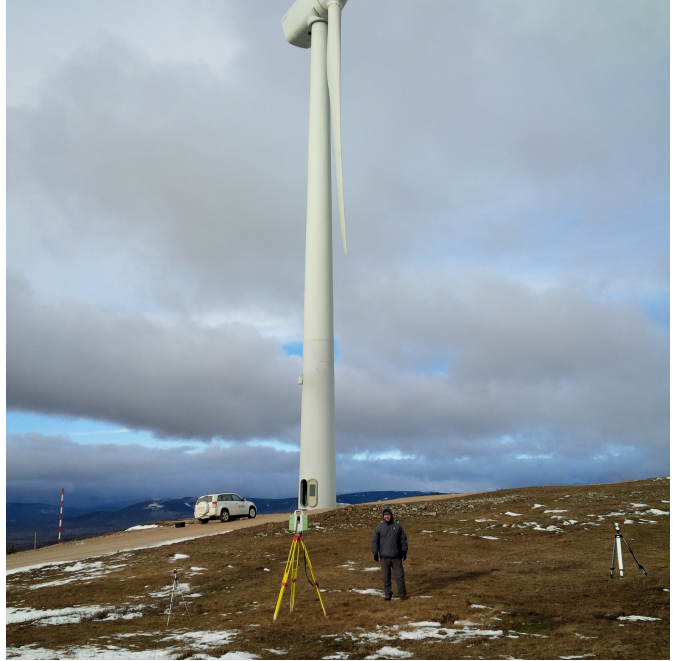
Figure 10. Photo of the measurement moment in a wind